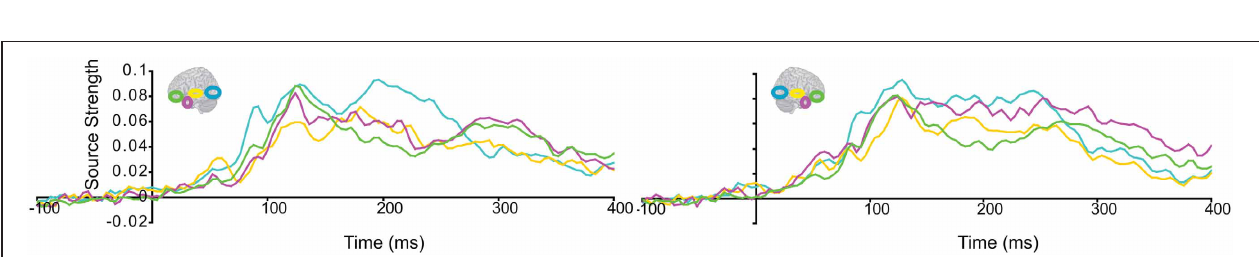
during AV trials showed a similar bilateral pattern of decreas- ing responses in pO, accompanied by increasing responses in the AT and IPC regions, during 0–400 ms ( Figure 7 ). Repeated Measures ANOVA with factors Hemisphere (2), ROI (4), and Time (4) showed a significant ROI by Time interaction. This was driven We analysed the AV trials further, to test for responses unique